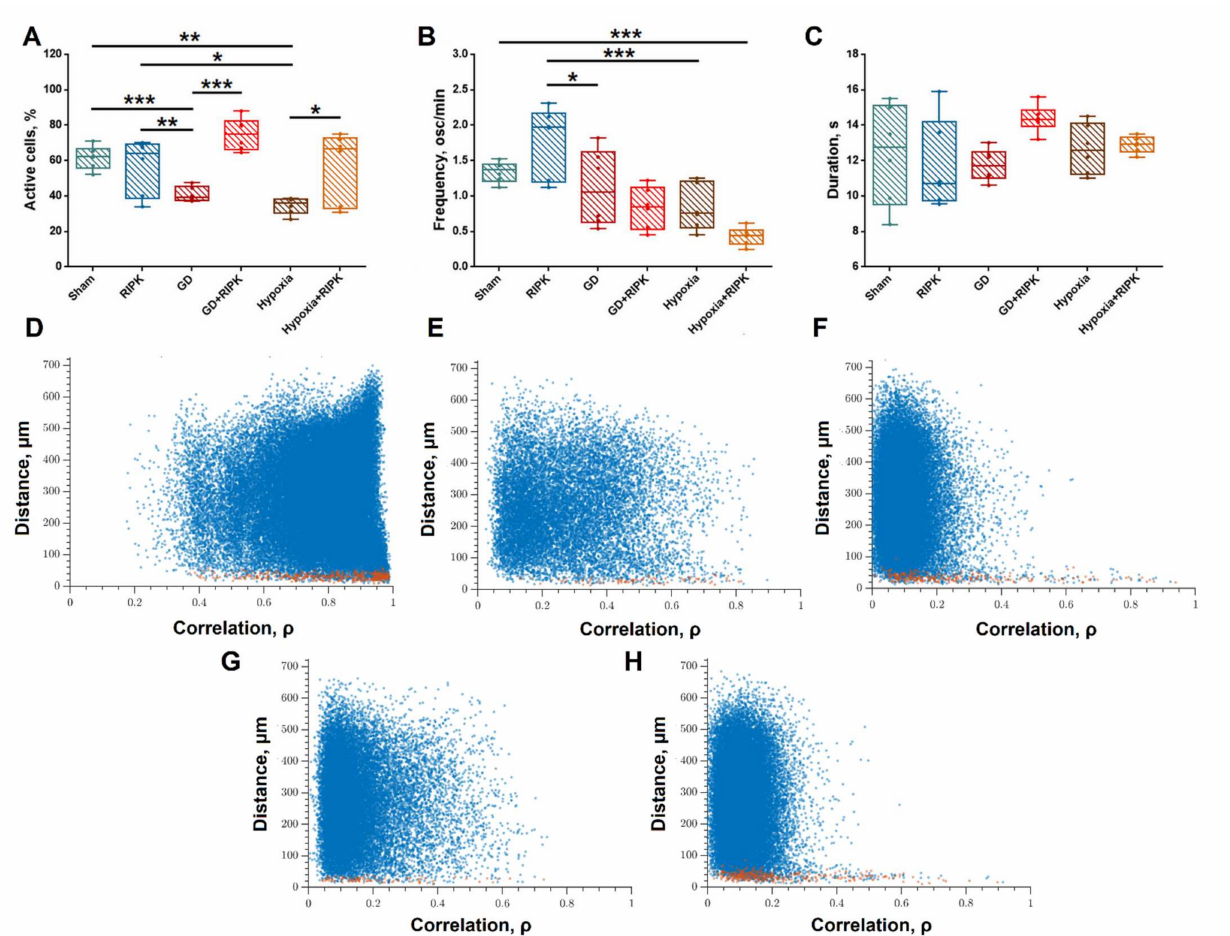
Figure 2. Analysis of calcium activity. ( A – C )—Main parameters of calcium activity of primary hippocampal cultures together with the blockade of intracellular kinases. ( A )—Active cells—the cell number with at least one recorded oscillation divided by the total cell number; F= 13.68. Sham vs. RIPK—NS; Sham vs. GD p ≤ 0.001; Sham vs. GD + RIPK—NS; GD vs. GD + RIPK p < 0.001; Sham vs. Hypoxia p = 0.005. Sham vs. Hypoxia + RIPK—NS; Hypoxia vs. Hypoxia + RIPK p = 0.026; ( B )—Frequency. osc/min. F= 10.91. Sham vs. RIPK—NS; Sham vs. GD NS; Sham vs. GD + RIPK—NS; GD vs. GD + RIPK NS; Sham vs. Hypoxia NS. Sham vs. Hypoxia + RIPK— p = 0.001; Hypoxia vs. Hypoxia + RIPK NS; ( C )—Duration of calcium oscillation. F= 1.93. NS. * p ≤ 0.05, ** p ≤ 0.01, *** p ≤ 0.001 Two-way ANOVA followed by Bonferroni post-hoc test for multiple comparisons. ( D – H )—Relationship between the level of signal similarity and the distance between pairs of cells. (red dots are pairs of neighboring cells; blue dots are pairs of distant cells). The x -axis is a measure of the similarity between pairs of cells, calculated as the maximum value of cross-correlation, taking into account the signal delays. Each point is determined by a coordinate on the x -axis—the level of signal similarity—and on the y -axis—the distance between a pair of corresponding cells. ( D )—Sham, ( E )—GD, ( F )—GD + RIPK1, ( G )—Hypoxia, ( H )—Hypoxia + RIPK1. The x -axis is the measure of similarity between pairs of cells, calculated as the maximum value of cross-correlation, taking into account signal delays. Each point is determined by a coordinate on the x -axis—the level of signal similarity—and on the y -axis—the distance between a pair of corresponding